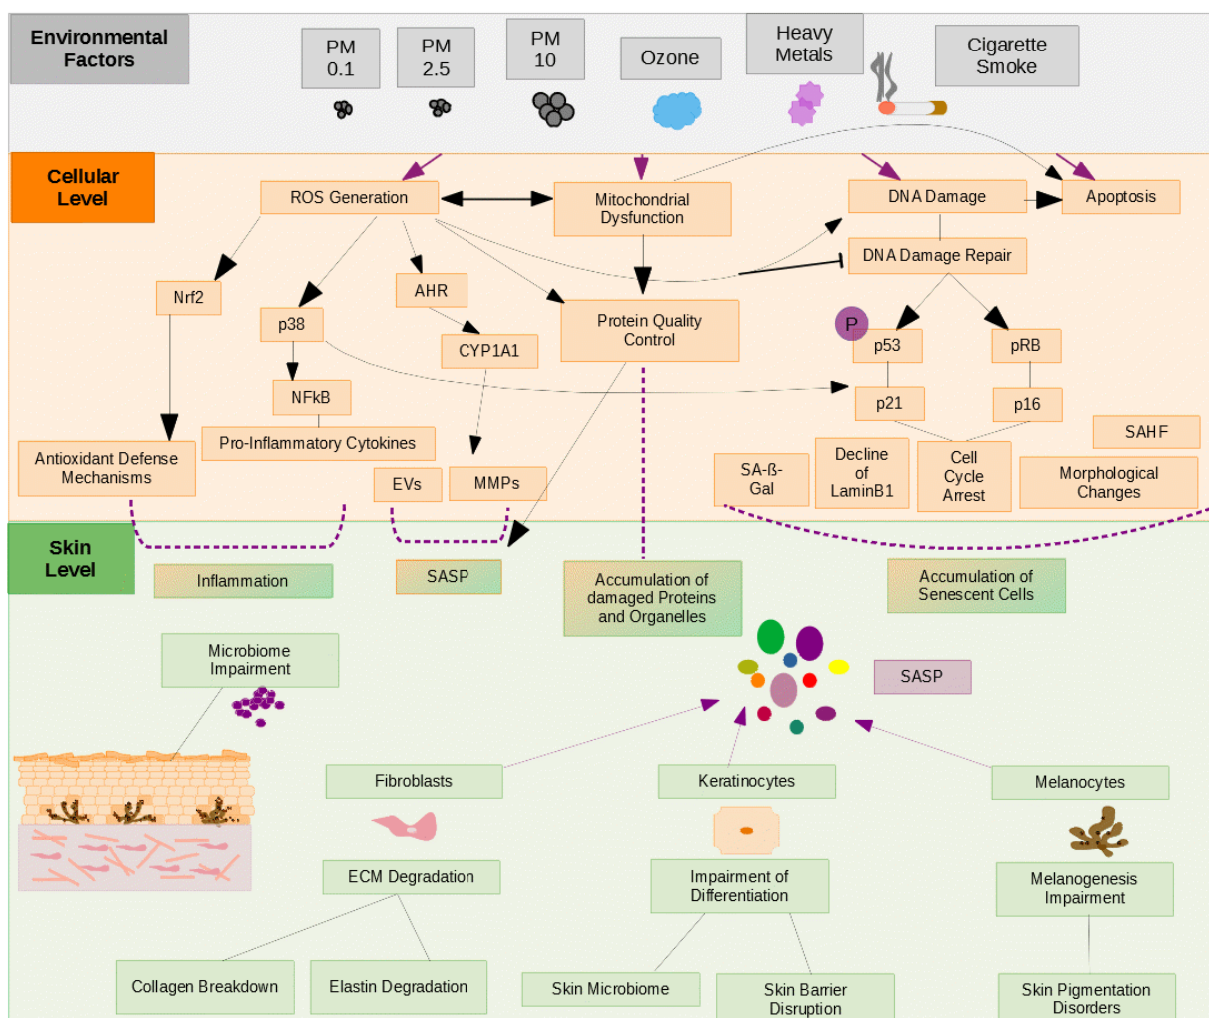
Figure 2. Schematic diagram showing the main signaling pathways involved in the process of cellular senescence which are contributing to skin aging. Pollutants act over many signaling pathways that control cell cycle progression and transcriptional regulation of genes involved in inflammation.